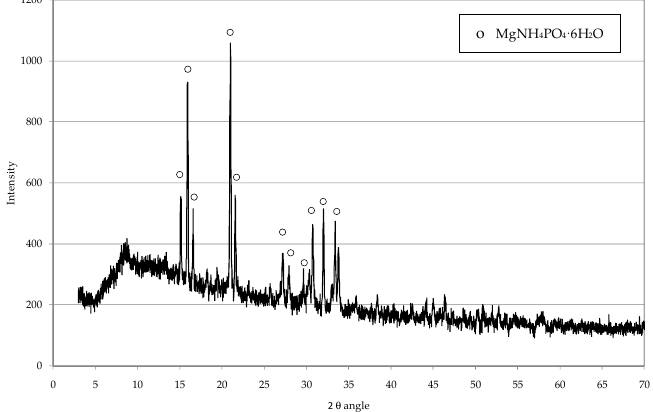
Figure 5. Diffractogram of solid produced from the leachate treatment using industrial-grade reagents, simultaneously dosed.